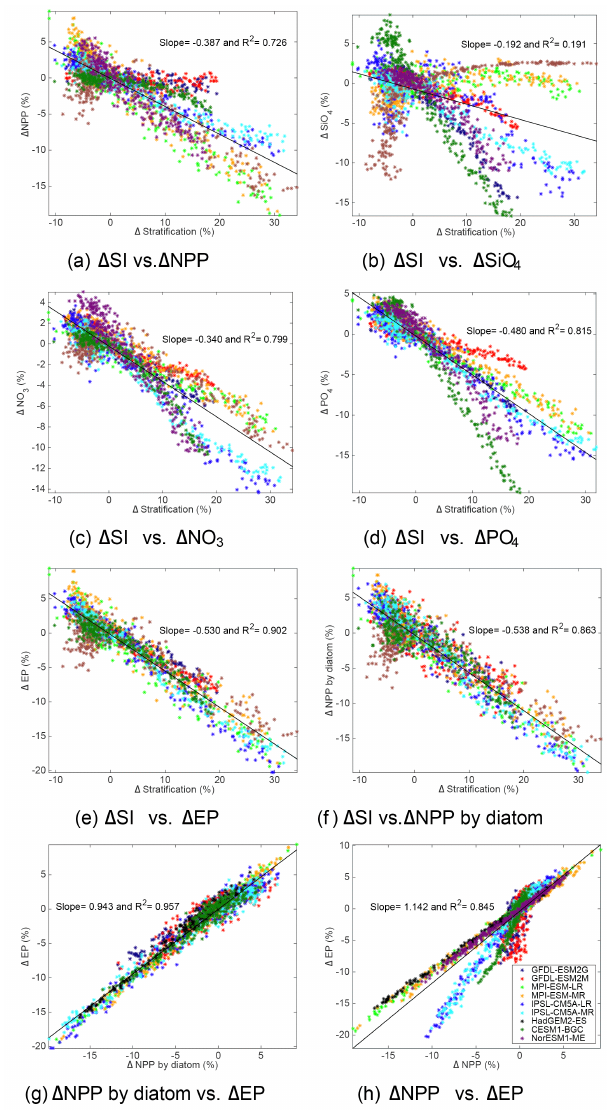
Figure 7. Relationships are shown between the relative percent change in surface stratification with climate and the relative change in several biogeochemical variables including net primary produc- tion (NPP) (a) , silicate (b) , nitrate (c) , phosphate (d) , export pro- duction (EP) (e) , the fraction of NPP by diatoms (f) . EP is plotted against the change in the fraction of NPP by diatoms (g) and against the change in NPP (h) . All changes are relative to the 1990s and plotted over 1850–2100. These time series are derived from global annual mean